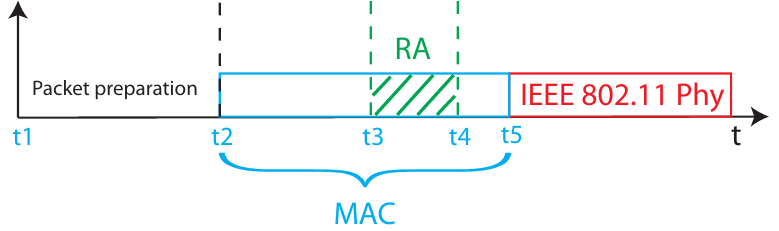
Figure 3. Timings related to the transmission of a